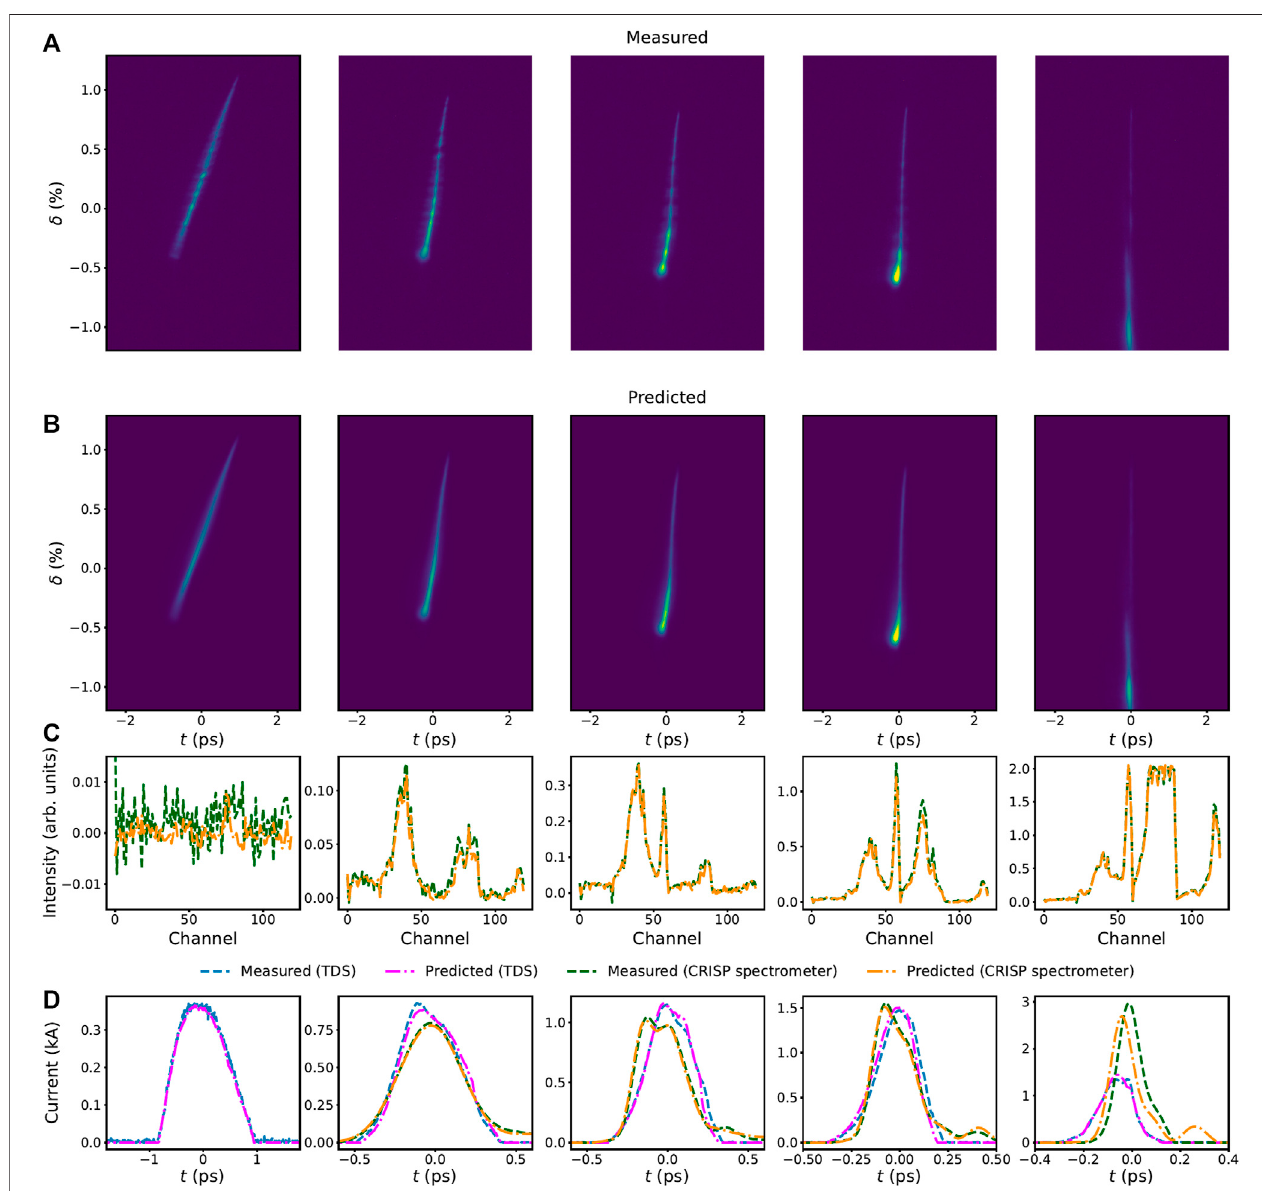
FIGURE 5 | Five typical results from the test data of a dataset of WP1. The compression strength increases monotonically from left to right. (A) Measured LPS images. δ denotes the fractional energy deviation. (B) Predicted LPS images. (C) Comparisons between the measured and predicted spectra from the low-frequency grating set of the CRISP spectrometer. (D) Comparisons of the current pro fi les calculated from the measured and predicted LPS images as well as reconstructed from the measured and predicted spectra.